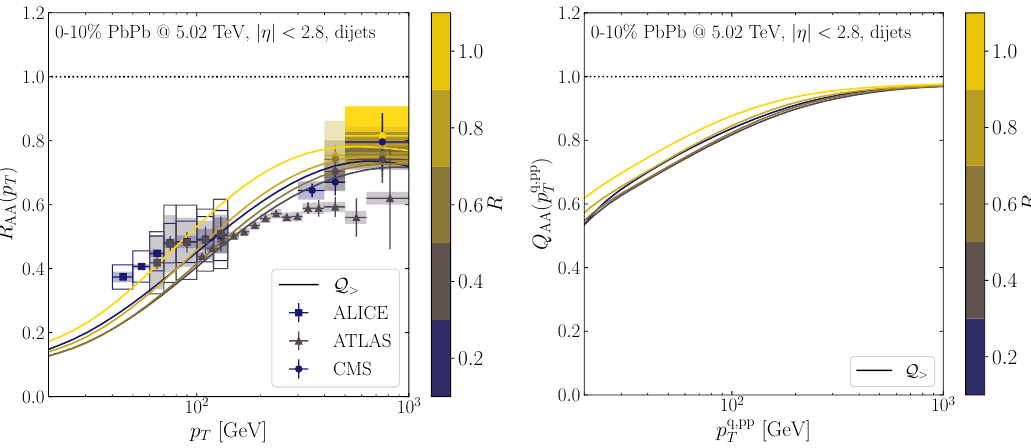
Figure 5 . The R AA (left panel) and Q AA (right panel) from eqs. (4.2) and (4.5), respectively, for single-inclusive jets in dijets events in 0–10% PbPb collision at are chosen to reproduce the R = 0 . 4 ATLAS [53] measurement. Data from ALICE [57] and CMS [58] are also